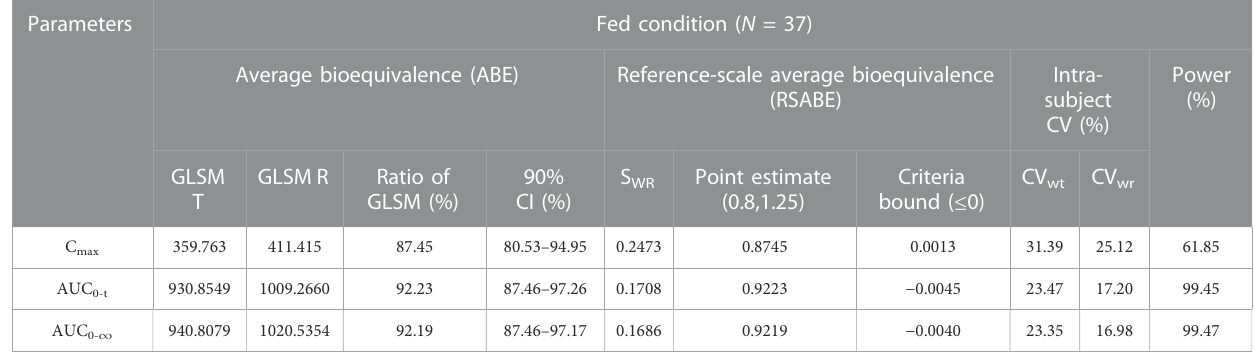
TABLE 4 Bioequivalence assessment of pharmacokinetic parameters of esomeprazole after a single dose 20 mg of test and reference esomeprazole magnesium enteric-coated tablet in healthy Chinese subjects under fed conditions.